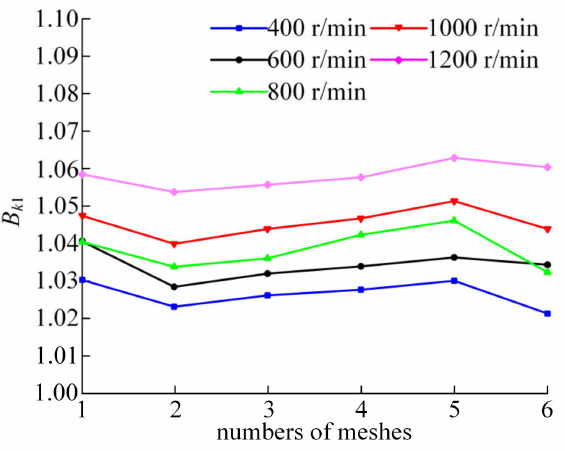
Figure 9. Load proportional coefficient curves under different input